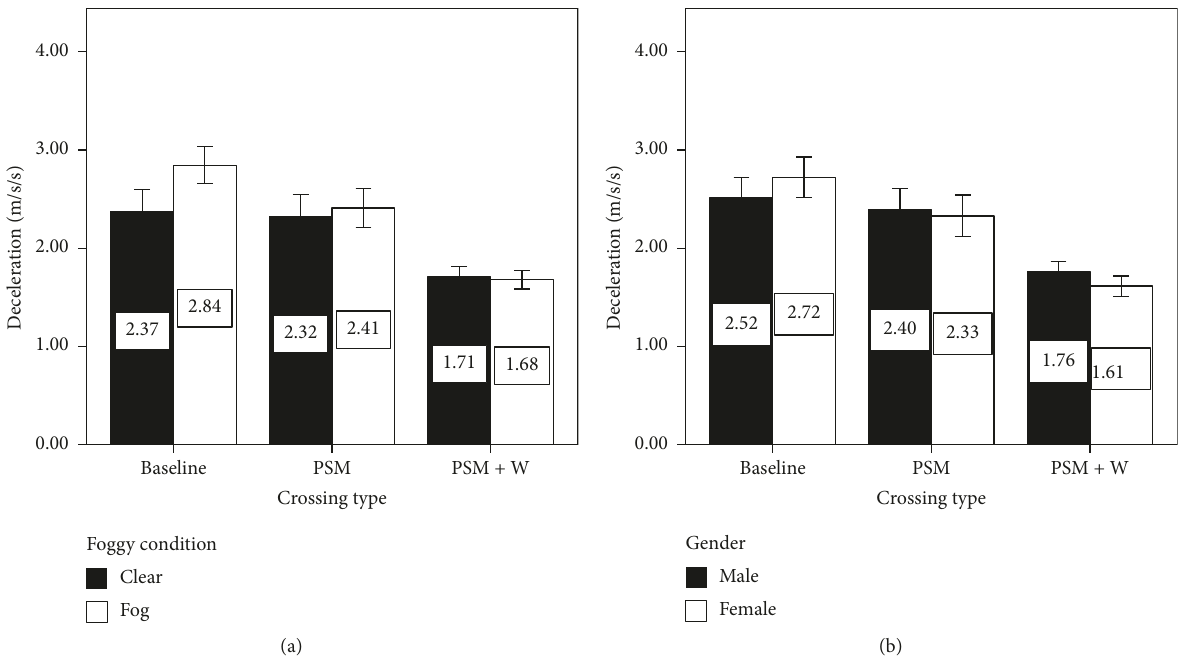
Figure 14: Mean decelerations under different crossing types. (a) The interaction effect between crossing type and foggy condition; (b) the interaction effect between crossing type and gender.